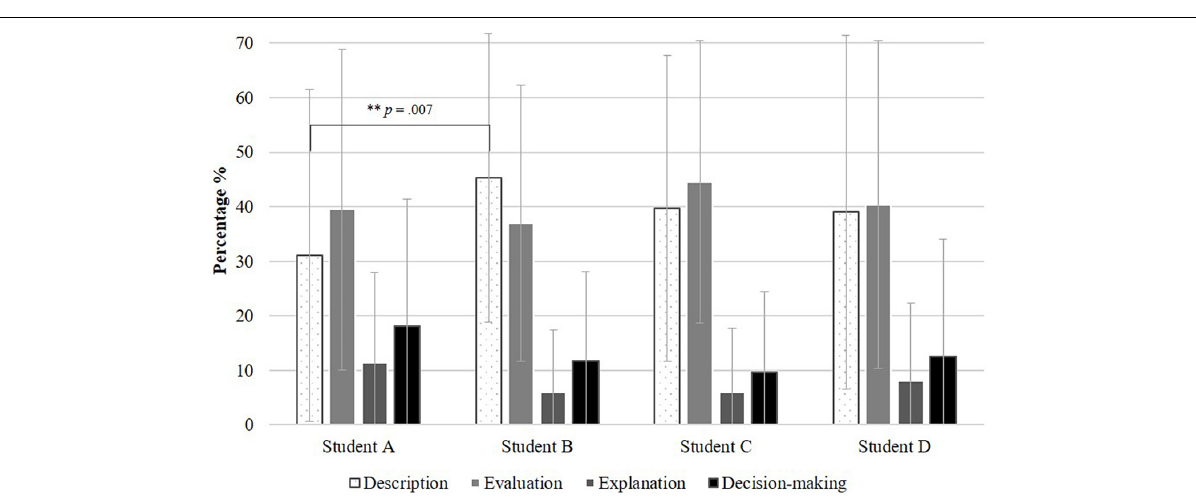
FIGURE 7 | Differences in knowledge-based reasoning activities for the four simulated students with the following significance level: ** p <